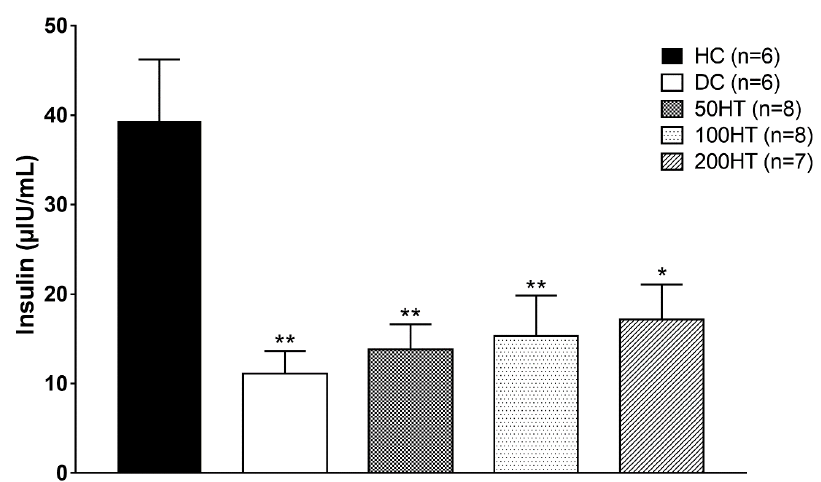
Figure 8. Effect of horsetail on fasting plasma insulin. The * and ** indicates significant difference from HC group ( p < 0.05 and p < 0.01, respectively).